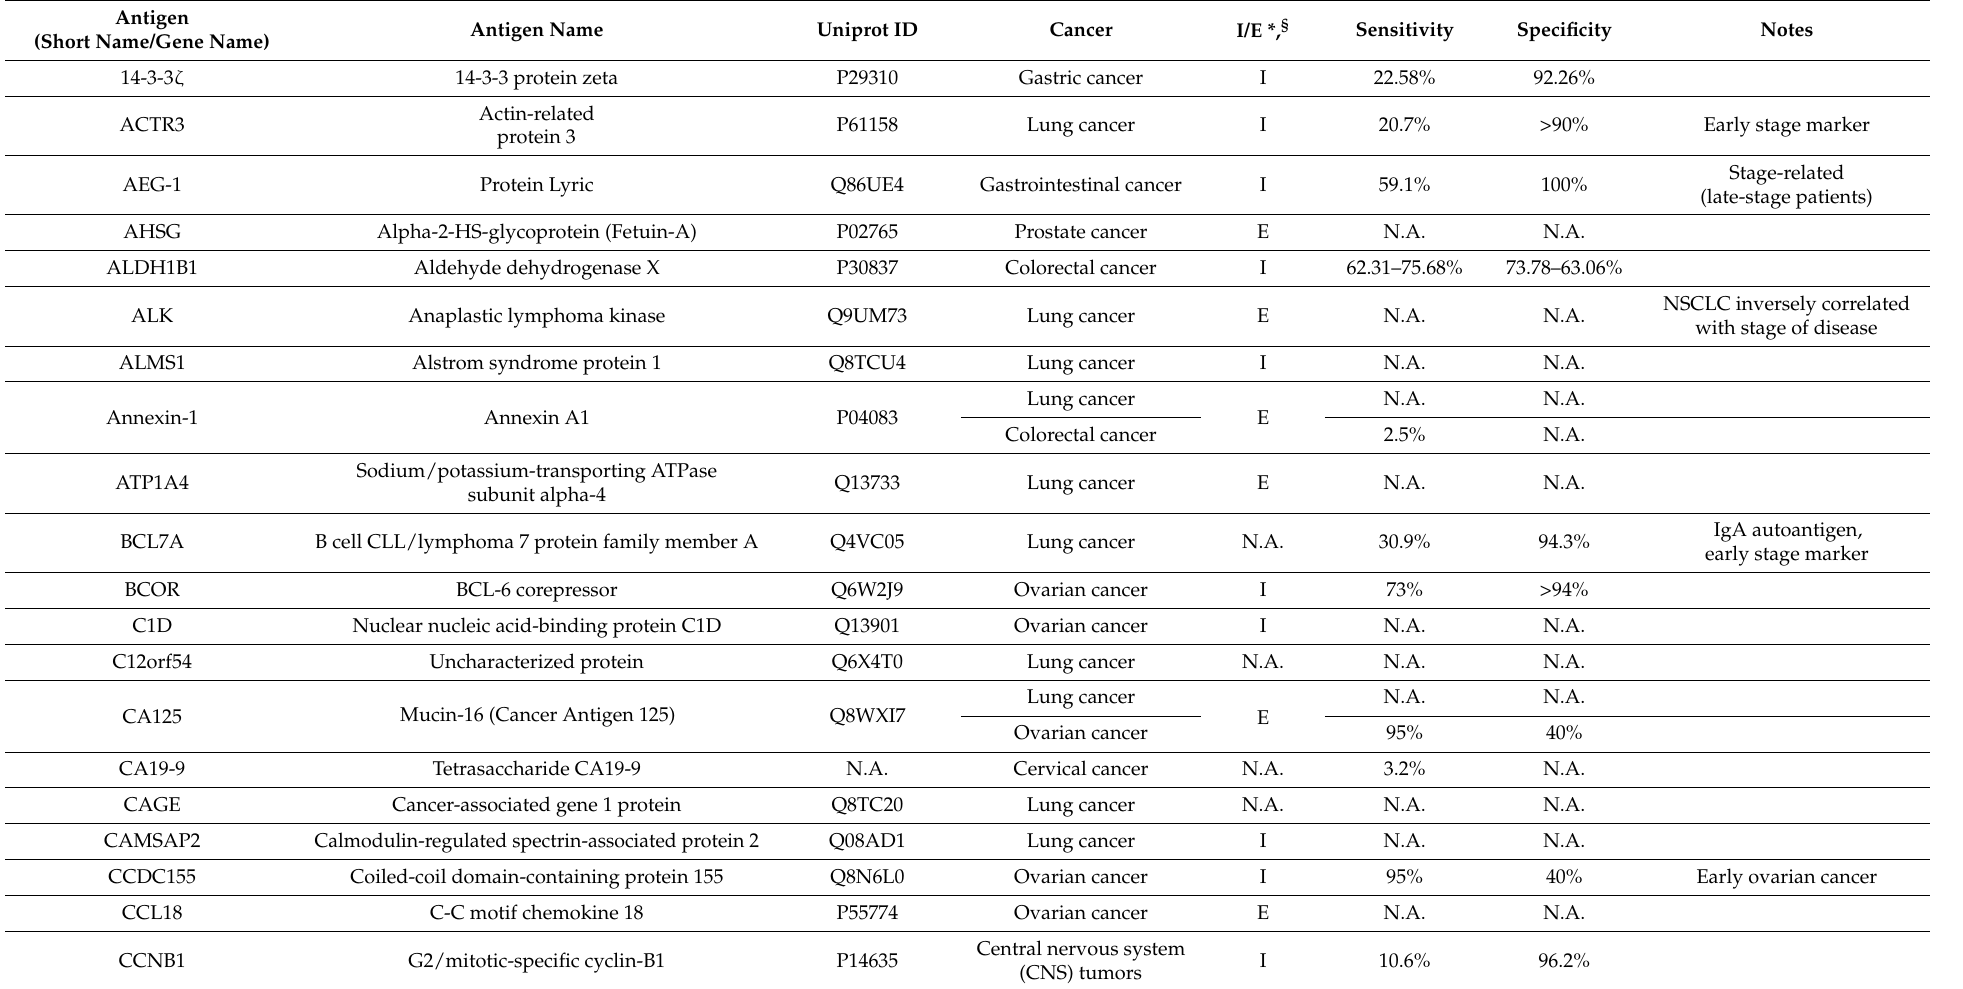
Table 1. Non-comprehensive list of antigens involved in auto-antibody production in